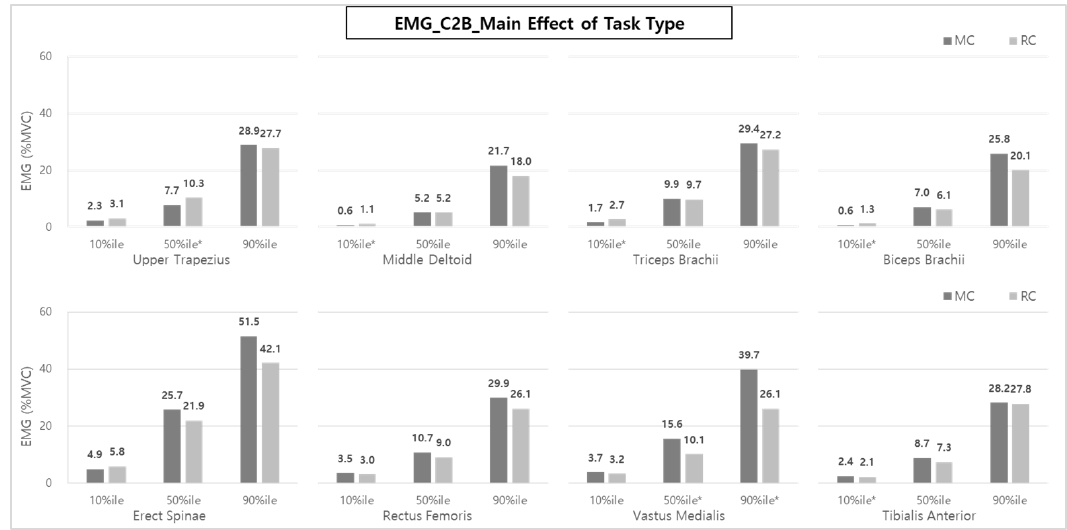
Figure 9. The effect of task type on each muscle activity during C2B. Asterisk (*) indicates that the difference between means is statistically significant at p < 0.05.